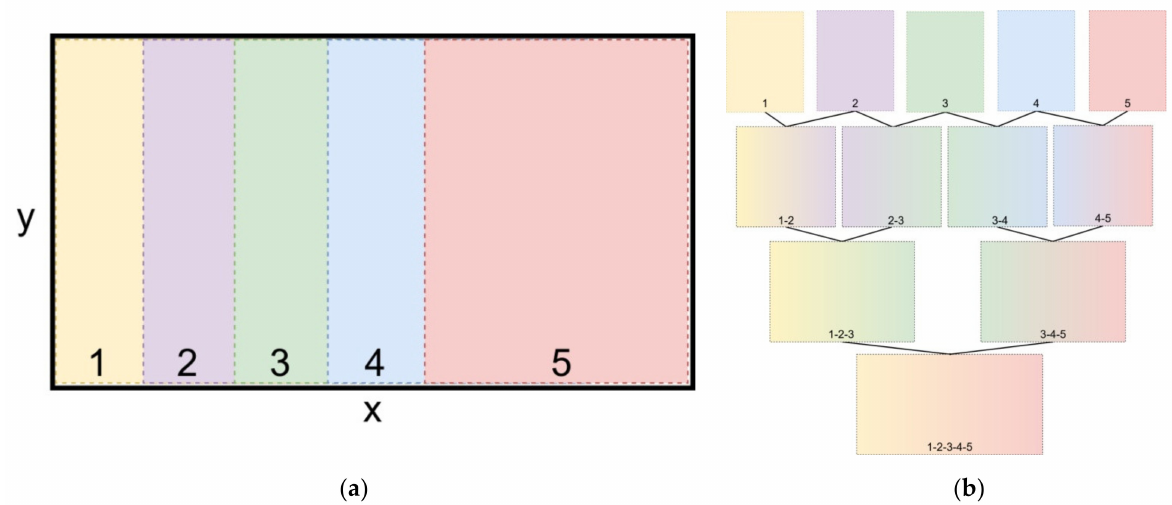
Figure 12. ( a ) Garden parcel segmentation for the 5 images’ acquisition and; ( b ) Image stitching